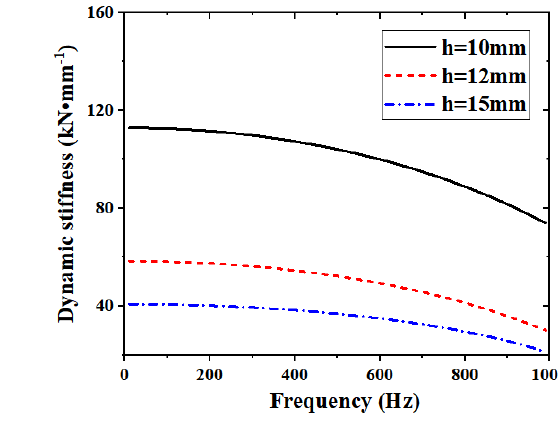
( b ) Figure 11. The finite element model meshing of ( a ) the first-stage vibration isolator, and ( b ) the